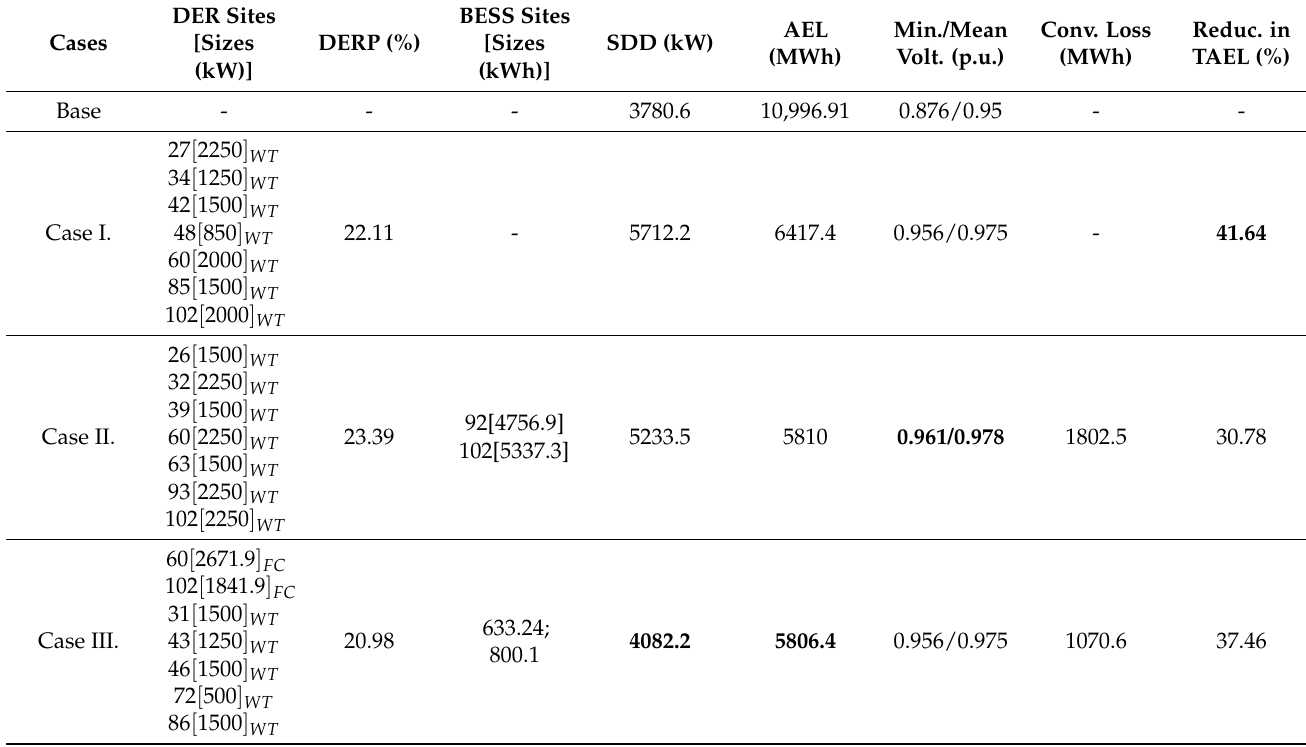
Table 6. Optimal sites and sizes of mixed DERs in 108-bus Indian distribution system obtained by IDA two-stage optimiza- tion